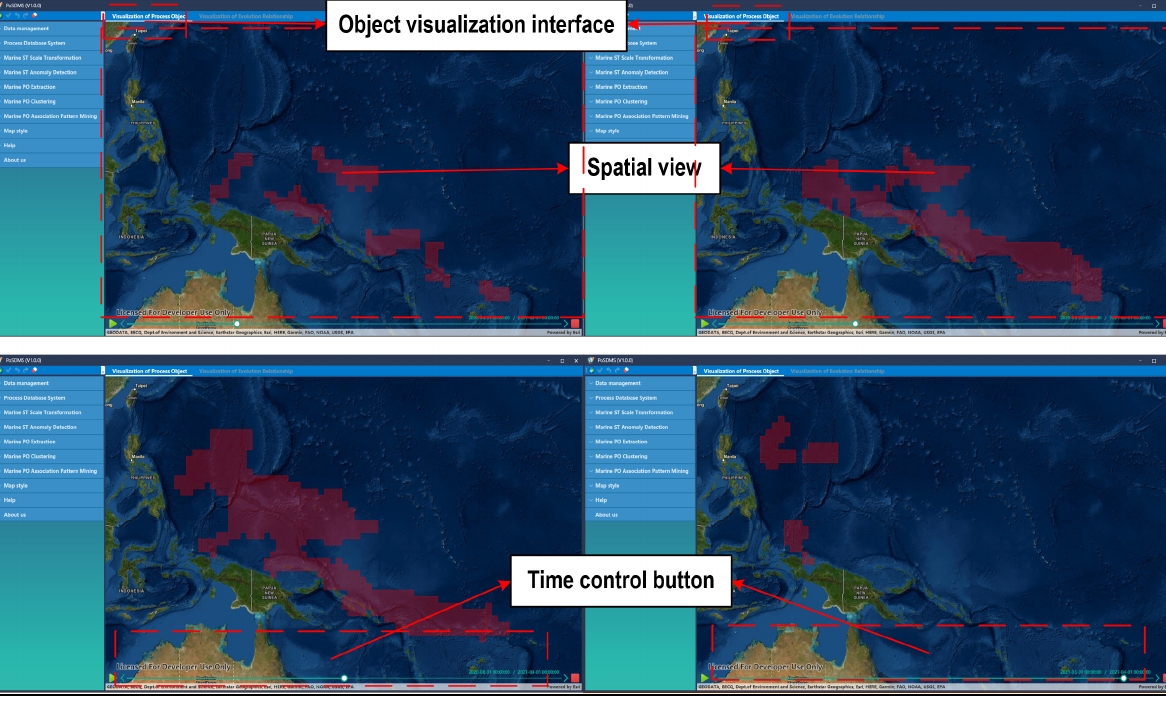
Figure 12. Evolutionary relationship of a specified process object of SSTA. 4.3. Clustering Pattern of SSTA Evolutions To more thoroughly explore and analyze evolution patterns of SSTA, a process object of SSTA was generalized into a trajectory of SSTA in space and time. Thus, we developed a process-oriented spatiotemporal trajectory clustering method named PoSCM (Process- oriented Spatiotemporal Clustering Method). PoSCM calculated similarity measurements